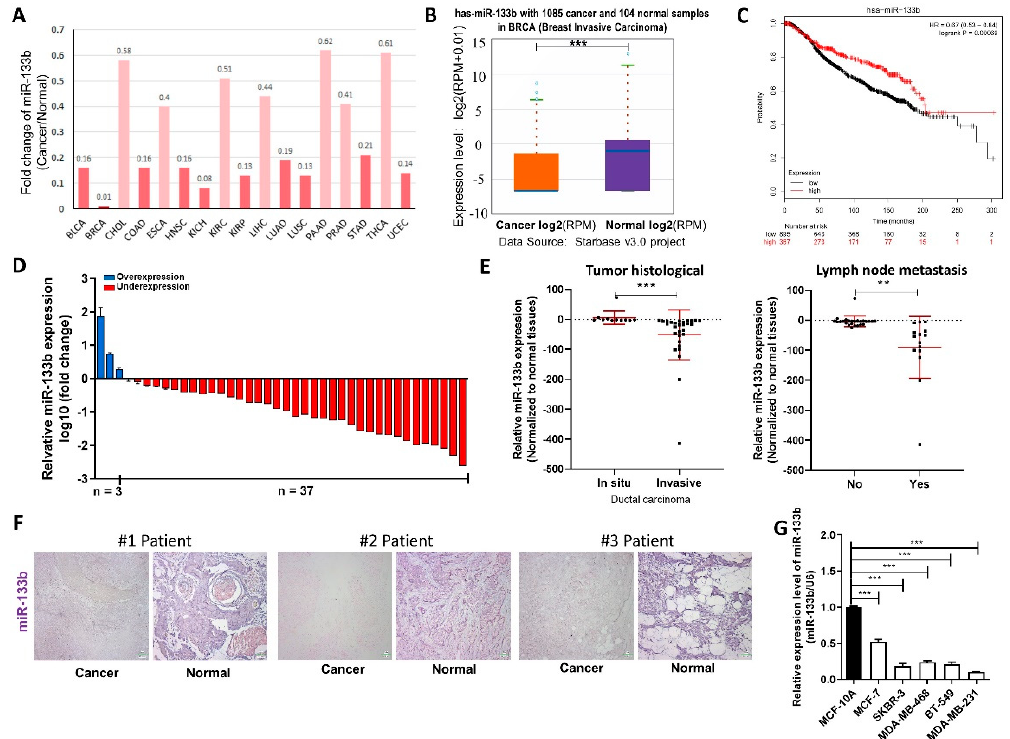
Figure 1. miR-133b is down-regulated in breast cancer cells. ( A , B ) Foldchange of miR-133b in 17 types of cancer tissues compared to their adjacent normal tissues ( A ) and expression levels of miR-133b in 1085 breast cancer tissues and 104 normal breast tissues ( B ) in StarBase public database from the TCGA project. ( C ) Overall survival analysis of breast cancer patients based on miR-133b expression ( n = 916, log-rank test). Data was analyzed using Kaplan Meier Plotter (www.kmplot.com). ( D ) miR-133b levels were detected in 40 pairs of human breast cancer tissues and corresponding adjacent normal tissues by qRT-PCR. ( E ) miR-133b levels in breast cancer patients with di ff erent tumor histological (left), with (indicated with ‘yes’) or without (indicated with ‘no’) lymph node metastasis (right). ( F ) In situ hybridization (ISH) analysis of miR-133b expression levels in breast cancer tissues (Cancer) and their adjacent normal tissues (Normal). Representative locked nucleic acid in situ hybridization (LNA-ISH) images from patients #1, #2 and #3 are shown. Scale bar, 100 µ m. ( G ) miR-133b levels were detected in di ff erent breast cancer cells compared with normal breast cells. * p < 0.05; ** p < 0.01; *** p < 0.001.